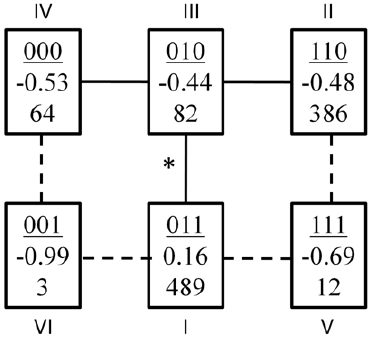
Figure 3. Parsimony tree of alleles present at 4gamete block 325 (chromosome 3, position 126.3). Values in boxes represent, from top to bottom, SNP scores each allele, best linear unbiased estimate of allelic effect, and number of lines carrying that allele. The edge separating alleles 010 (III) and 011 (I) was associated with heading date in the TreeScan analysis. Alleles VI and V were recombinant alleles not included in the parsimony tree and therefore the dotted edges were not included in the TreeScan analysis.